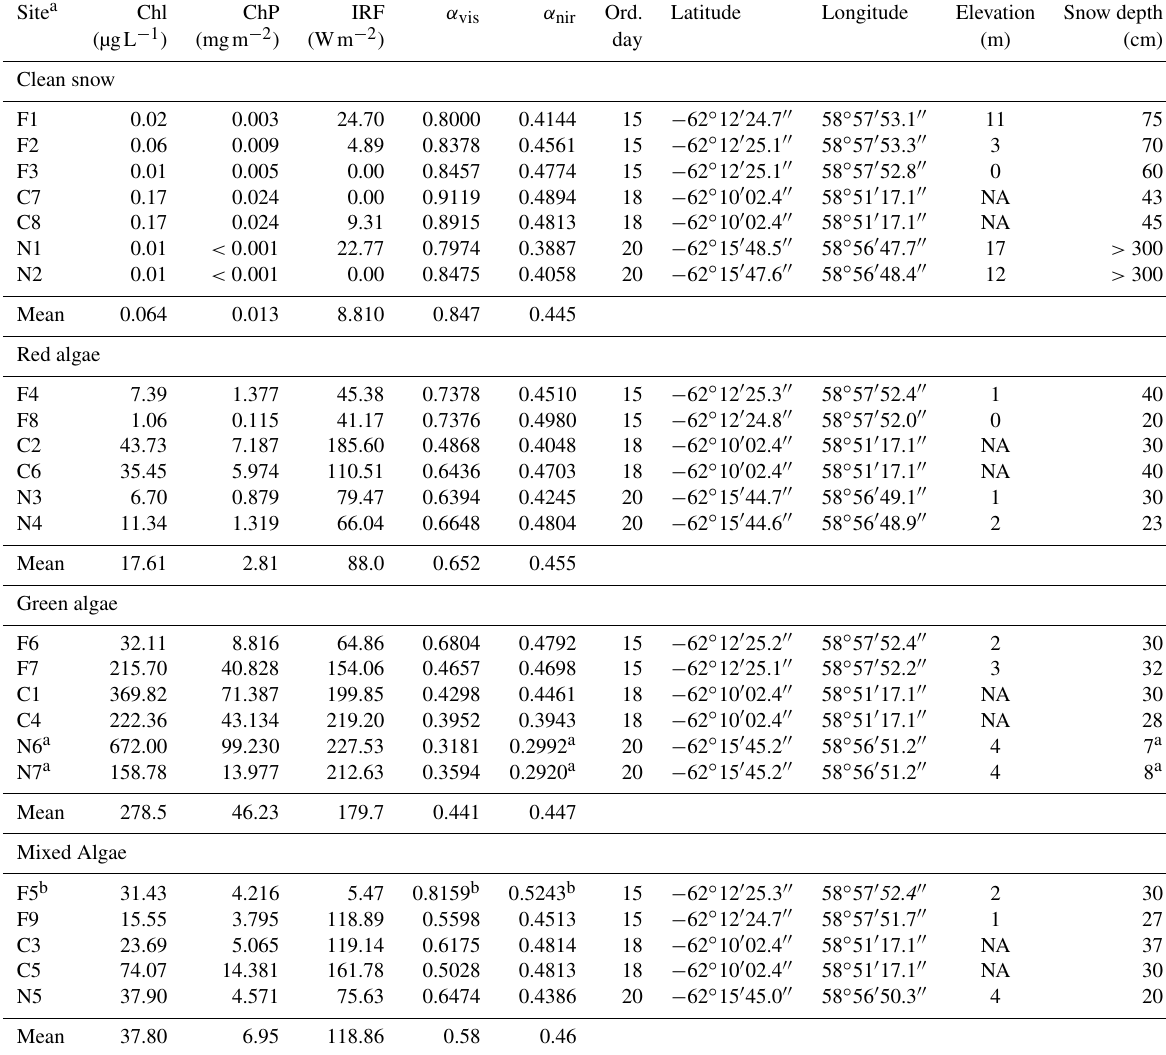
Table 1. Pigment concentration, albedo and RF calculated for each snow type sampled with corresponding